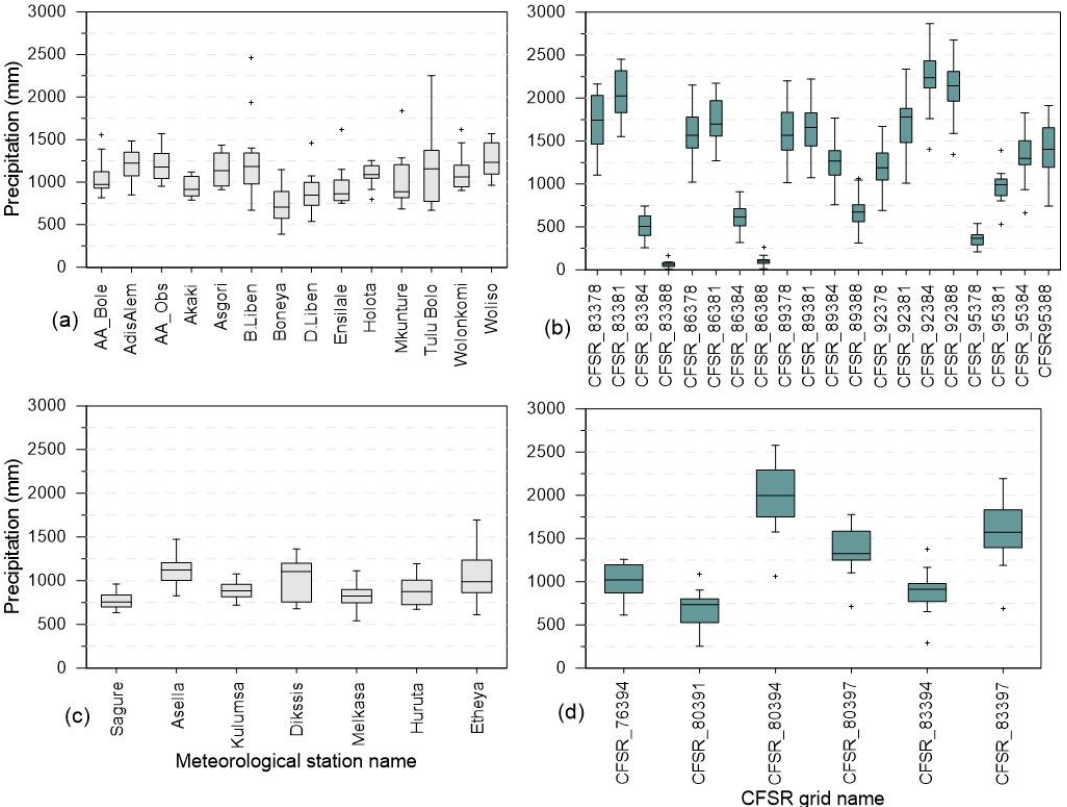
Figure 5. Average annual rainfall distribution of each station and grid (1990–2004) from ( a ) the conventional weather station data and ( b ) the CFSR weather for the Melka Kunture sub-basin; and ( c ) the conventional weather station data and ( d ) the CFSR weather for the Keleta sub-basin.